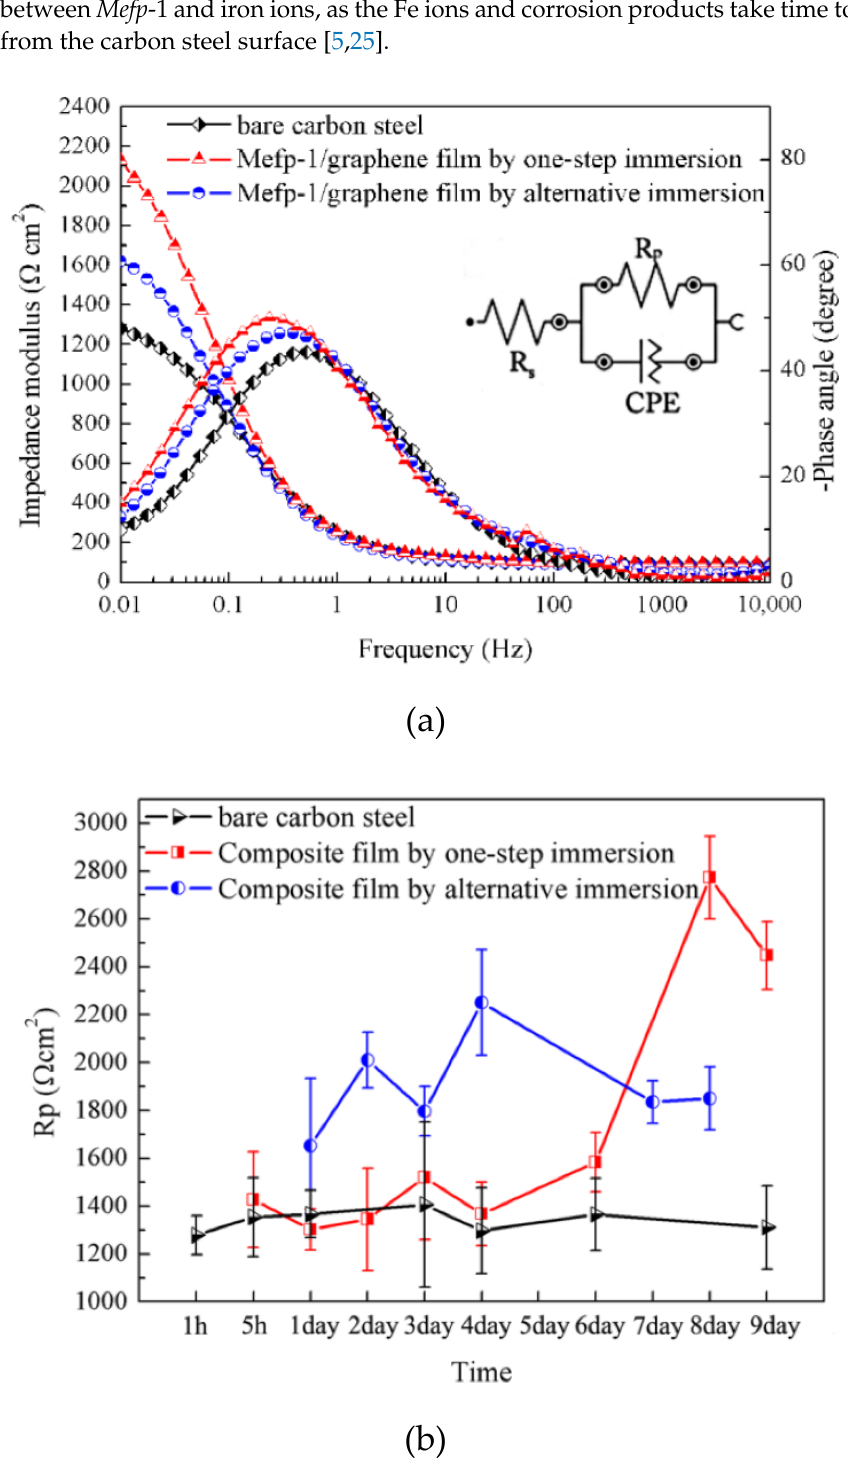
Figure 1. Electrochemical impedance spectrum (EIS) of the composite film on carbon steel prepared by immersion methods: ( a ) Bode plots after 8 days exposure; ( b ) changes of polarization resistance ( Rp ).